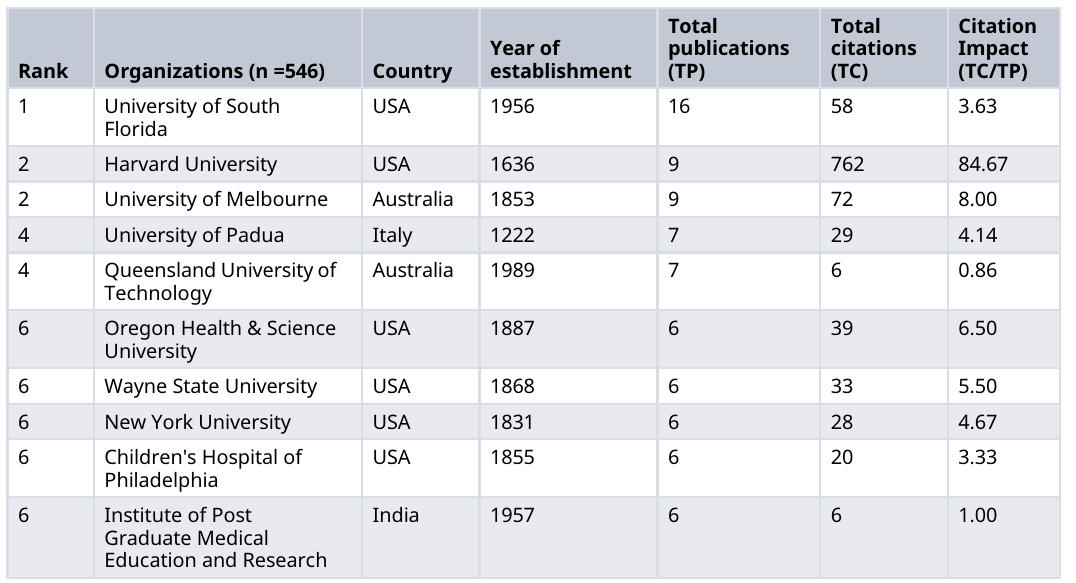
Table 5. Top ten contributing